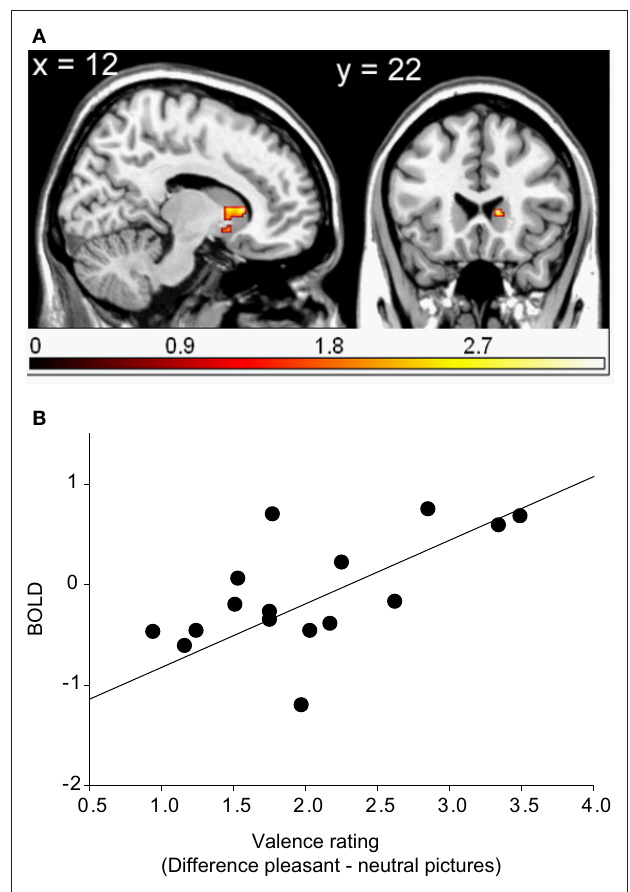
Figure 2 | region of interest (rOi) activation. (A) Cluster of significant correlation between right caudate head activation (peak voxel at 12, 22, 6) of the contrast pleasant relative to neutral pictures and subjective valence ratings overlaid on a single subject T1 scan (overlay threshold: p < 0.05; minimum cluster size of k = 5). Color-coded t-values are shown. (B) Correlation between right caudate head activation (peak voxel at 12, 22, 6) of the contrast pleasant relative to neutral pictures and subjective valence ratings.